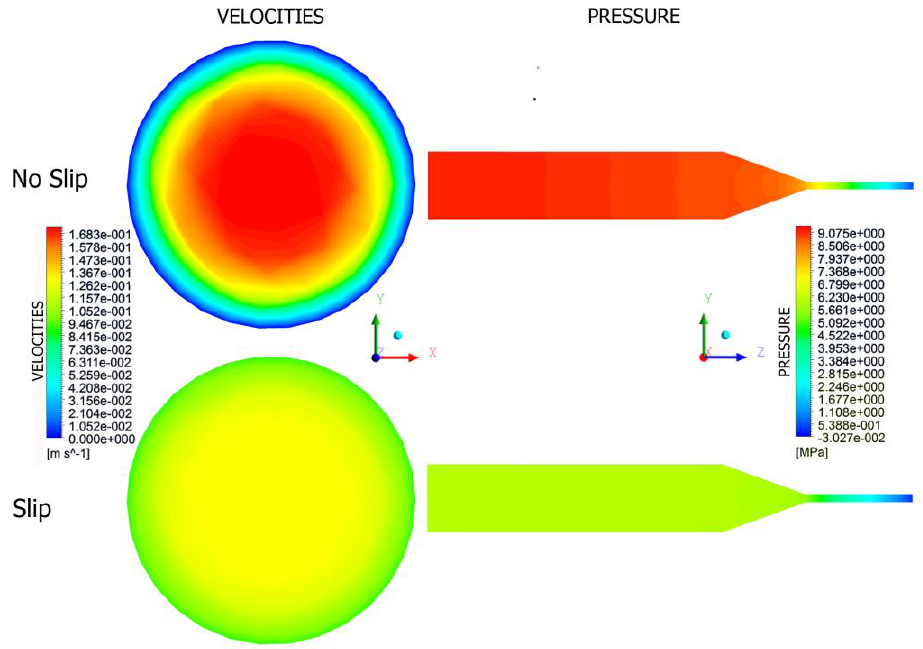
Figure 15. Die flow simulations.